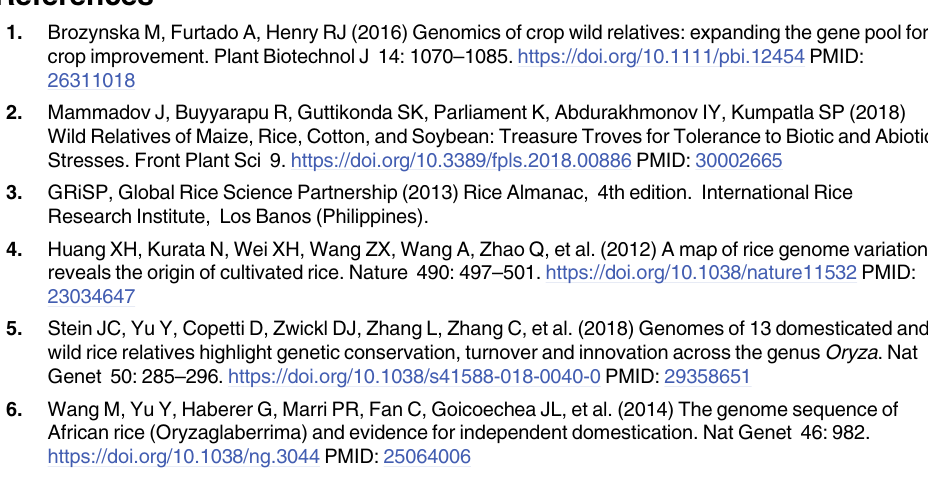
S1 Table. List of germplasm used in the screening experiment. S2 Table. Comparison of mean values and variability of selected traits of domesticated and wild rice species grown in control conditions, acute Fe stress, or chronic Fe